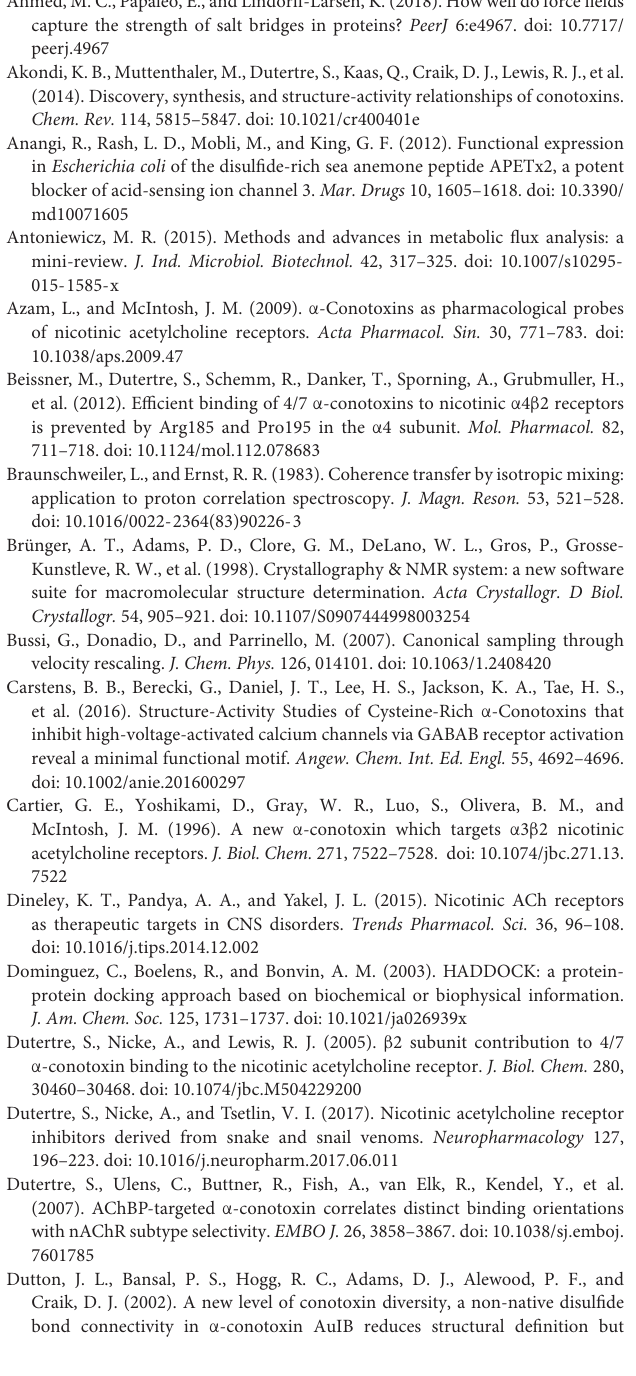
recombinantly expressed TxIA (red) and synthetic ribbon TxIA (blue). Small differences in chemical shift for the H N protons are observed for Cys3 and Cys16 between samples presumably due to a slight variation in pH between samples. FIGURE S4 | Comparison of the interactions between the position 5 of ribbon TxIA (A) and R5N (B) and R5D (C) variants at the α 7 nAChR in the